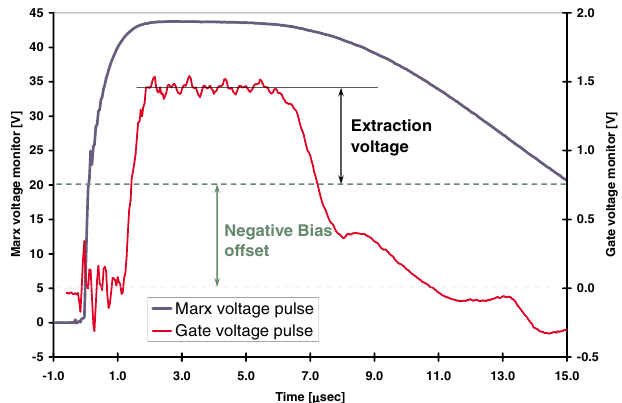
FIG. 3. (Color) Typical Marx voltage (blue) and gate voltage (red) pulses. The Marx voltage is viewed through a capacitive monitor, whose gain is 21 : 4 kV = V . The gate voltage is viewed through a resistive divider and an optical link. The negative dc bias offset and net extraction voltage are indicated. Ripples in the extraction pulse waveform represent electrical noise in the